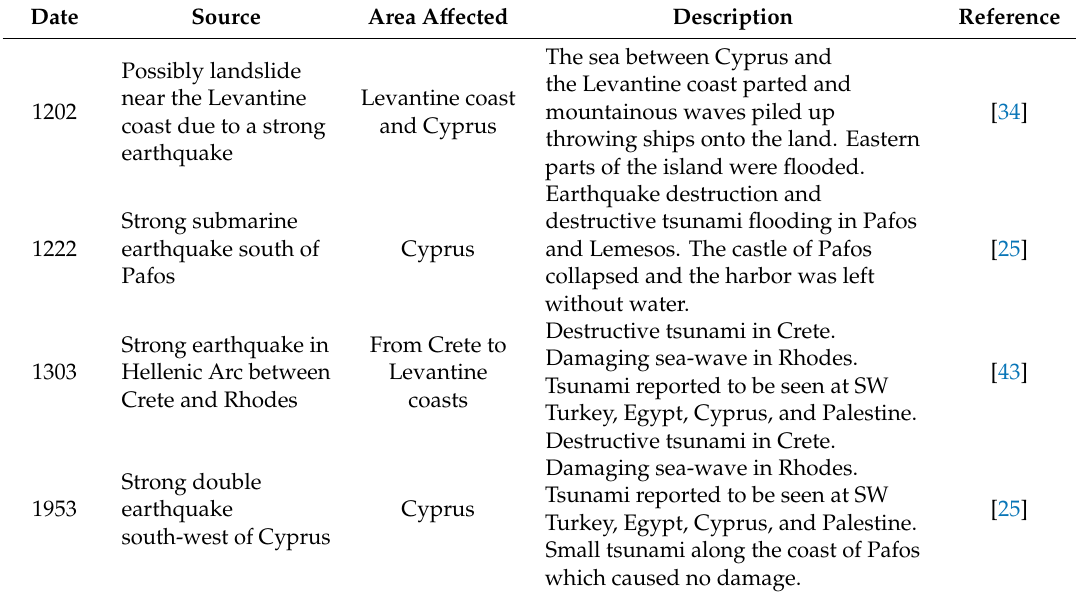
Figure 4. Simplified tectonic framework of the study area, within the eastern Mediterranean, where AM is the Anaximader Mountains, CB is Cilica Basin, DSFZ the Dead Sea Transform Fault Zone, FR the Florence Rise, EAFZ the East Anatolian Fault Zone, IB Iskenderun Bay, LLT Latakia–Larnaka–Tartus ridges, LB Levantine Basin (adapted from [33]). Table 1. The most important earthquakes and tsunamis to have affected Cyprus since 1200 AD [25,42,43].